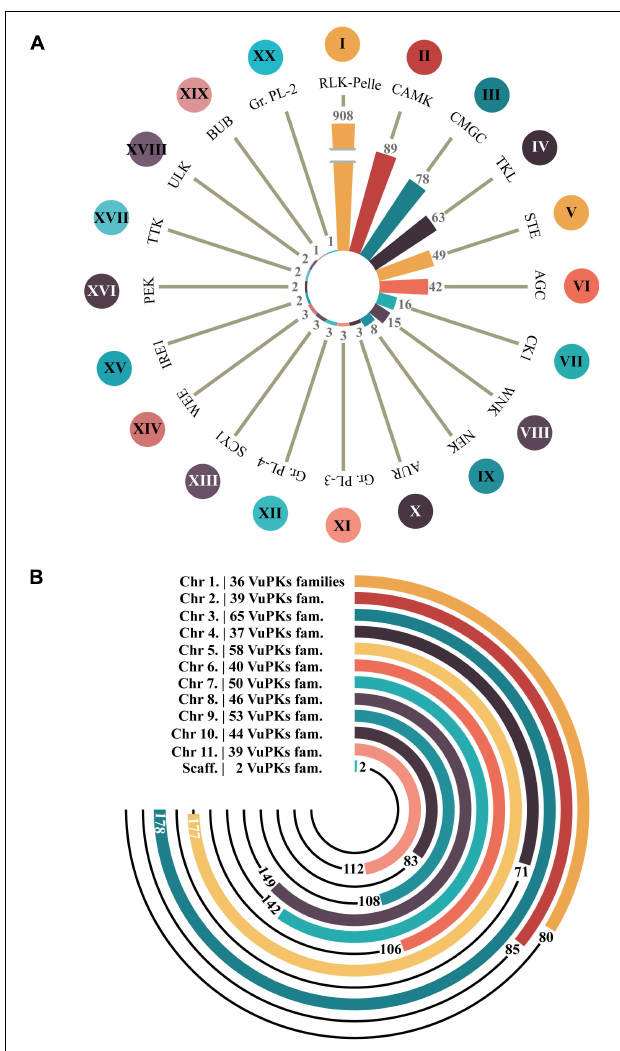
FIGURE 1 | Amount of bona fide VuPKs in the cowpea genome. (A) Twenty searched groups of VuPKs and their most abundant families (indicated by Roman numerals). (B) Chromosomal distribution of bona fide VuPK loci and respective number of families covered per chromosome (family and respective number of representatives): I, RLK-Pelle_DLSV (174); II, CAMK_CDPK (40); III, CMGC_CDK-CRK7-CDK9 (19); IV, TKL_CTR1-DRK-2 (14); V, STE_STE11 (33); VI, AGC_RSK-2 (24); VII, CK1_CK1 (11); VIII, WNK_NRBP (15); IX, NEK (8); X, AUR (3), XI, Group-Pl-3 (3); XII, Group-Pl-4 (3); XIII, SCY1_SCYL1 (2); XIV, WEE (1); XV, IRE1 (2); XVI, PEK_GCN2 (1) and PEK_PEK (1); XVII, TTK (2); XVIII, ULK_ULK4 (1) and ULK_Fused (1); XIX, BUB (1); and XX, Group-Pl-2 (1).